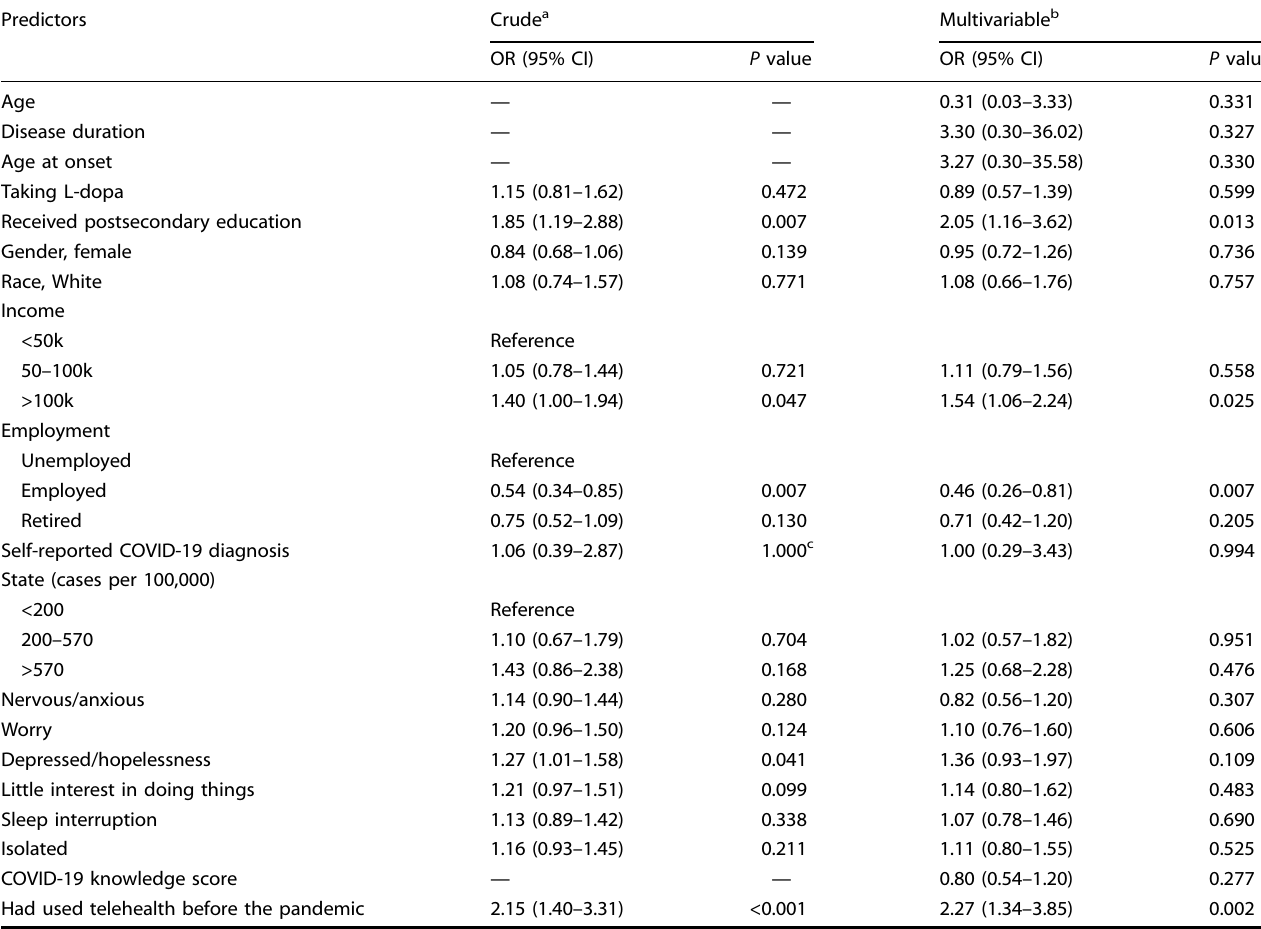
Table 3. Adjusted analysis using telehealth use during COVID-19 pandemic as